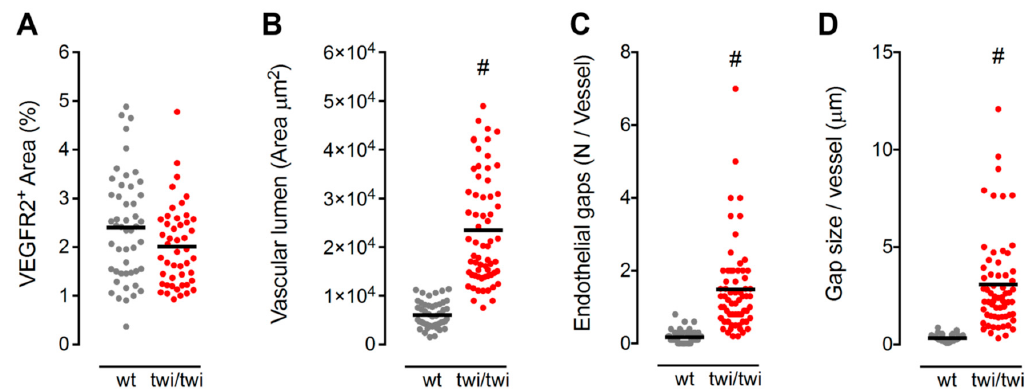
Figure 5. Quantification of BM vascular abnormalities in twitcher mice. ( A ) Quantification of the BM area occupied by VEGFR2 + diaphyseal SECs. Each dot represents the percentage VEGFR2 + area per microscopic field. ( B – D ) Morphometric parameters of VEGFR2 + diaphyseal SECs, including area of the vessel lumen ( B ), number of endothelial gaps per vessel ( C ), and size of endothelial gaps ( D ). For each parameter, dots represent the mean value measured in di ff erent microscopic fields. Horizontal black bars show the mean value. #, p < 0.001.